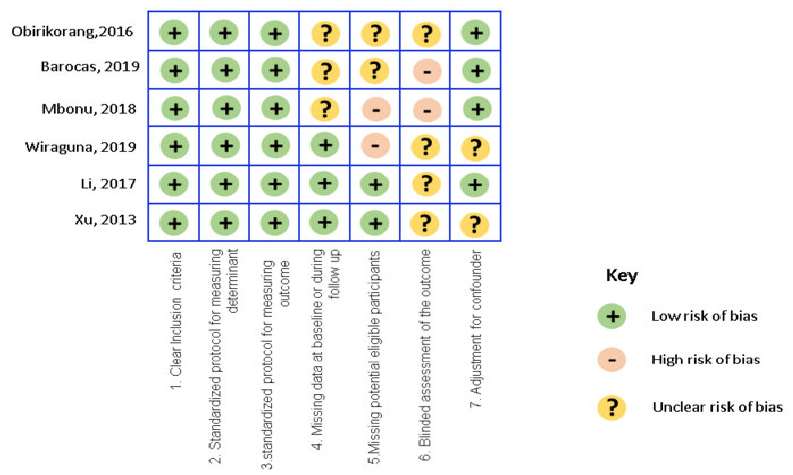
Figure 2. Risk of Bias